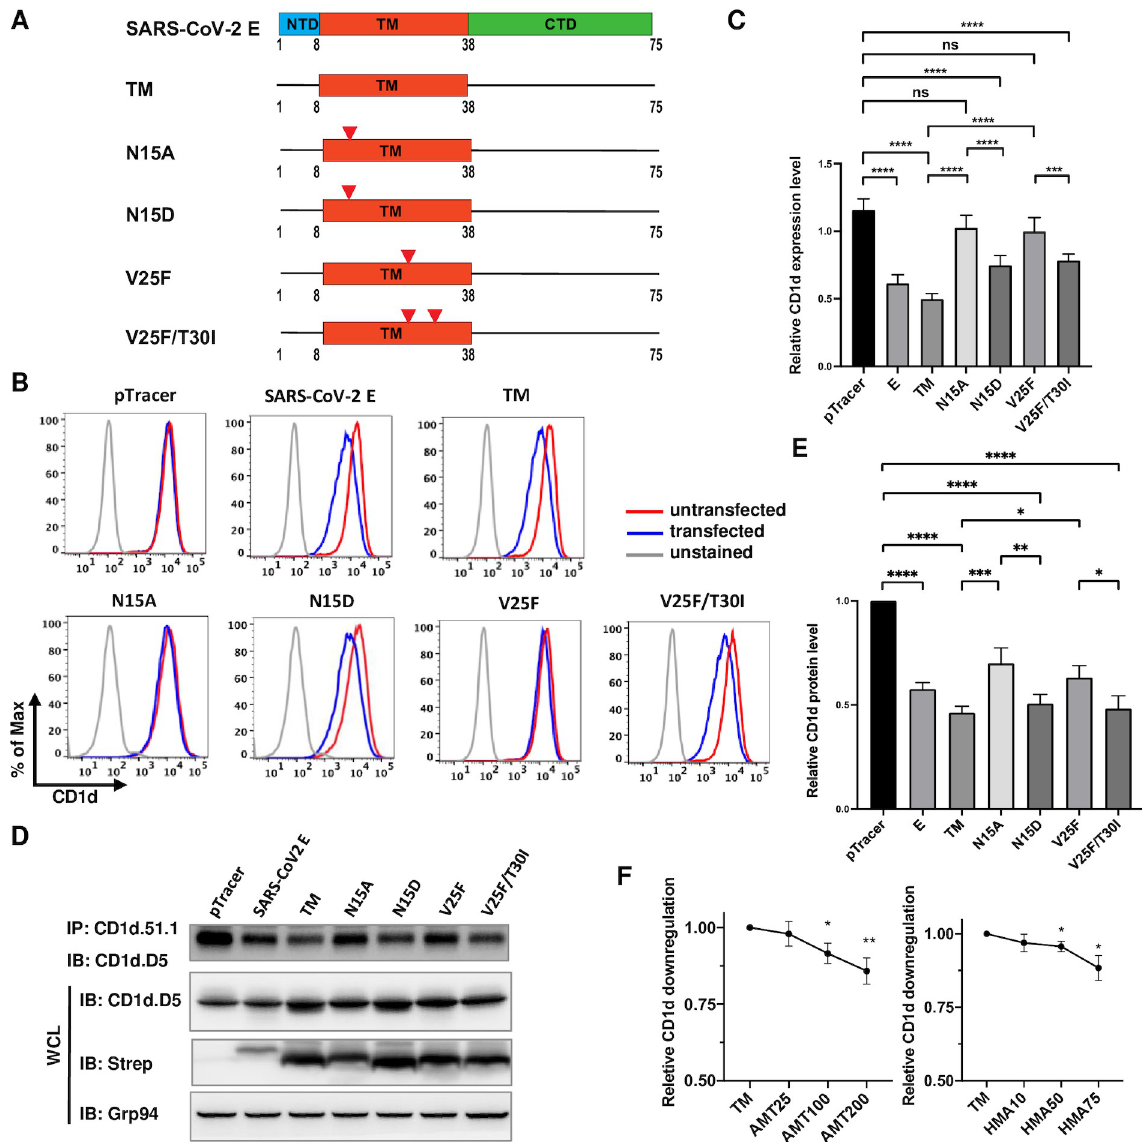
Fig 6. The putative ion channel function is required for E protein-mediated CD1d downregulation. (A). The domain structure of SARS-CoV-2 E protein and the mutagenesis schemes in its TM domain to ablate ion channel function (N15A and V25F) or to reconstitute ion channel function (N15D and V25F/T30I). (B, C). The effect of wild-type or mutant E proteins in downregulating cell surface CD1d levels in transfected 293T.CD1d cells was analyzed by flow cytometry. The relative CD1d expression level was calculated by dividing the MFI values of GFP-positive cells (transfected cells) by the MFI values of GFP-negative cells (untransfected cells). (D, E). 293T.CD1d were transfected with wild-type or indicated mutant E proteins and cell lysates were subjected to immunoprecipitation by anti-CD1d antibody (CD1d.51.1) and levels of mature CD1d protein were compared by western blotting. The relative CD1d protein level based on western blotting was calculated by dividing the chemiluminescence signal of CD1d protein in cells transfected with E gene or mutants by the chemiluminescence signal of CD1d protein in cells transfected with pTracer plasmid. (F). Ion channel inhibitors can revert E protein-mediated CD1d downregulation. 293T.CD1d cells were transfected to express the TM domain of E protein and treated with increasing concentrations of ion channel inhibitors, amantadine or hexamethylene amiloride (HMA). Forty-eight hours post transfection, cell surface CD1d expression was analyzed by flow cytometry. The relative CD1d downregulation upon treatment with ion channel inhibitors was calculated as described in “Materials and Methods”. Statistical analyses were performed by unpaired Student’s t test and one-way ANNOVA test (C-F). * , ** , *** , **** : p < 0.05, p < 0.01, p < 0.001, p < 0.0001. ns: not significant.